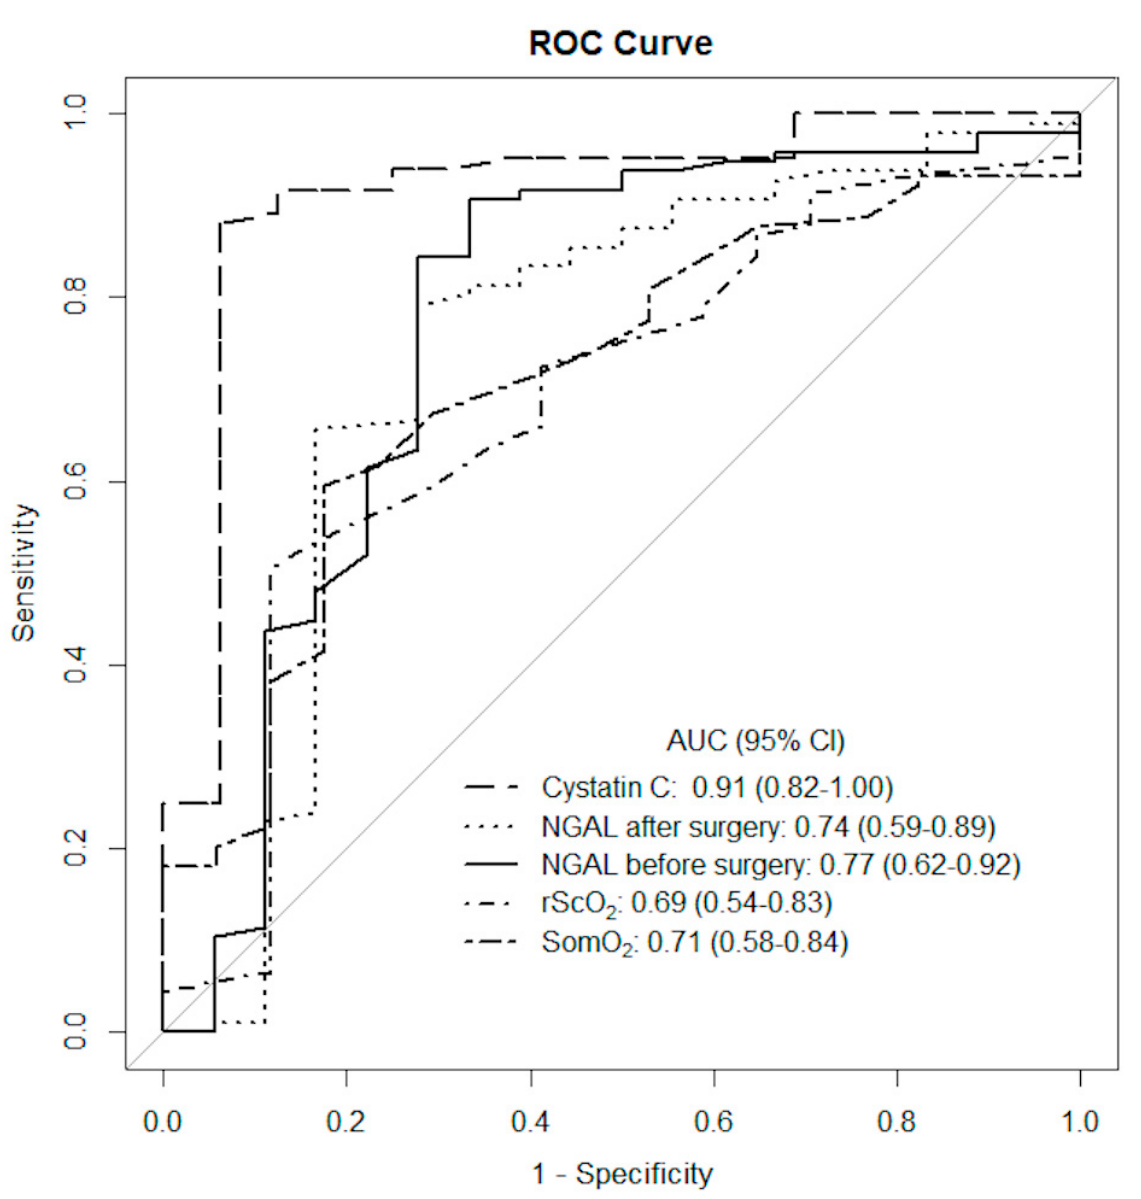
Figure 4. The accuracy of measured parameters as potential CS-AKI predictors based on the area (AUC) under the receiver-operating characteristic (ROC) curve. Table 3. Univariate logistic regression analyses for blood NGAL, cystatin, and NIRS cut-off values in CS-AKI prediction.